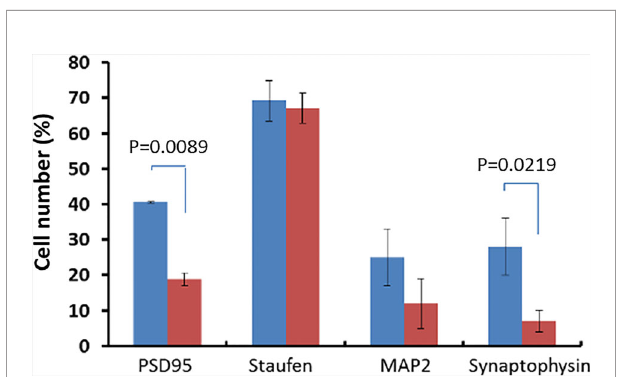
FIGURE 2 | De fi ciency of synaptogenesis under deletion of the Cd157 gene. Expression of synaptogenesis markers (PSD95, Staufen, MAP2, Synaptophysin) in the subgranular zone of the dentate gyrus of the hippocampus in CD157 − / − mice (red marker) and in the control group of mice (CD157 +/+ mice, blue marker). The number of positive cells is presented as a percentage of the total number of cells in the fi eld of view ( fi ve visual fi elds were evaluated). Two-way ANOVA (genotype effect, F (1.32) = 36.26, P = 0.0007) followed by Bonferroni ’ s post hoc test.